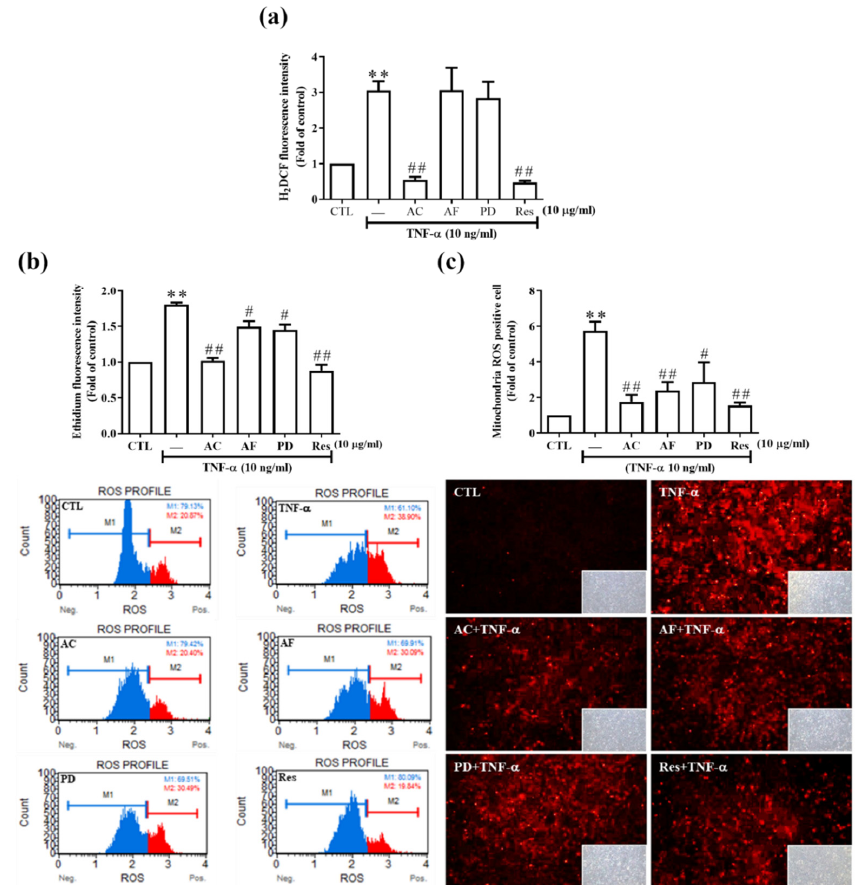
Figure 3. Antioxidant ability of AC, AF, Res, and PD in cells. ( a ) H 2 DCFDA (4 µ M) was added to starved cells at 37 ◦ C for 30 min, and cells were pre-treated with Res, AC, AF, and PD (10 µ g/mL), cultured for 2 h, and then stimulated with TNF- α (10 ng/mL) for 6 h. Cell lysates were collected and the H 2 DCF fluorescence values were read on a SpectraMax i3 microplate reader (excitation at 485 nm, emission detection at 530 nm); n = 4–8. ( b ) After the same treatment as that described in ( a ), cells were harvested (1 × 10 6 cells/mL), free radicals were stained with DHE, and a Muse ® Cell Analyzer was used for analysis; n = 3–4. ( c ) Cells seeded on glass slides were treated as in ( a ), and 5 µ M MitoSOX™ Red reagent was added in the dark for 1 h at 37 ◦ C. A fluorescence microscope was used to photograph the distribution of free radicals in the cells; n = 4–7. The results are presented as the mean ± SD and were analyzed using one-way ANOVA followed by Dunnett’s post hoc test. ** p < 0.01, compared with the untreated group. # p < 0.05, ## p < 0.01, compared with the TNF-